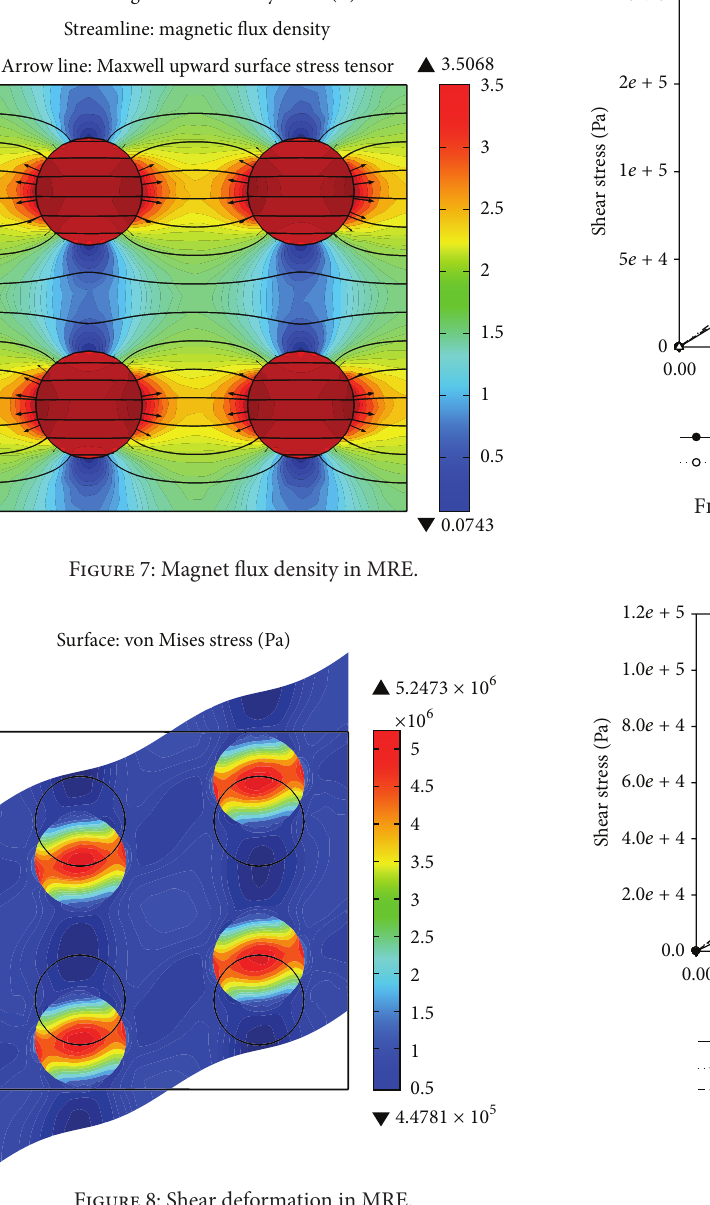
Figure 8: Shear deformation in MRE.